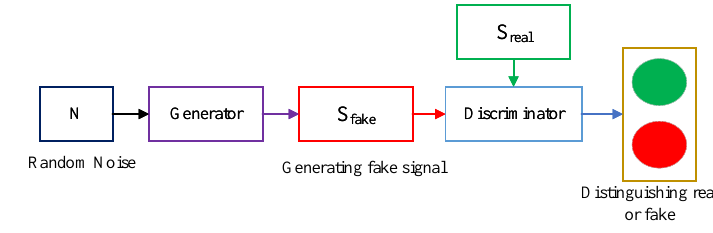
Figure 1. GAN sketch